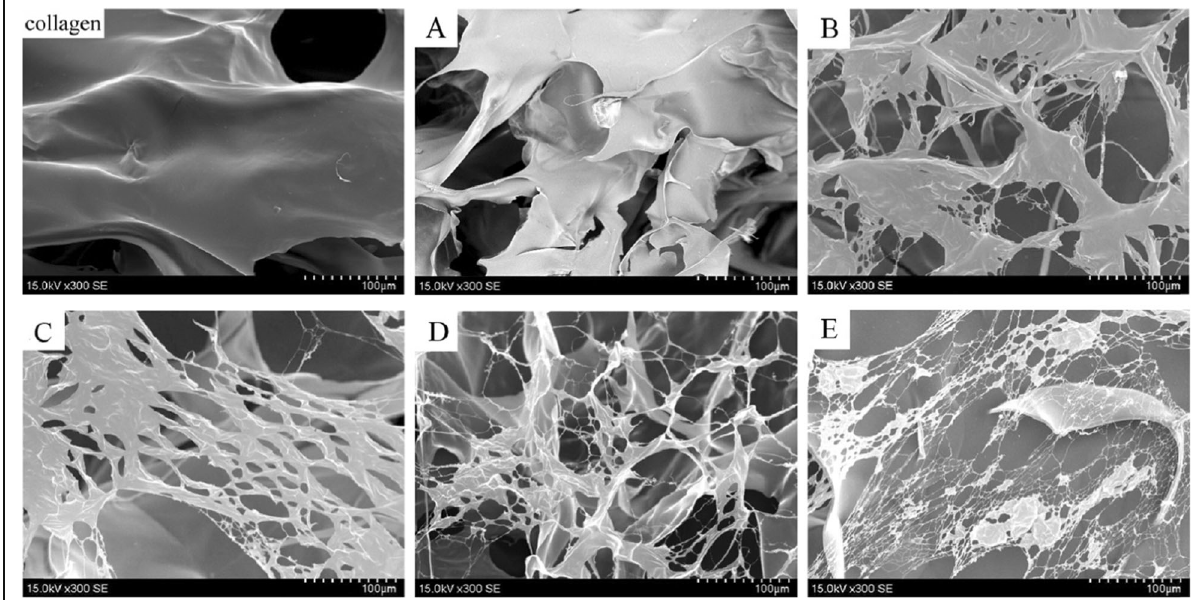
Fig. 2 SEM images of the native collagen and the insoluble collagen fibers derived from ILs: a Col/ILs-fibrils70%B. b Col/ILs-fibrils10%. c Col/ILs- fibrils30%. d Col/ILs-fibrils50%. e